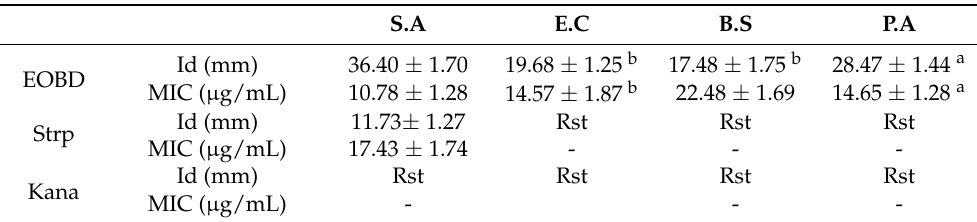
Table 3. The antibacterial effect of EOBD on the basis of the inhibition on solid medium and minimal inhibitory concentration